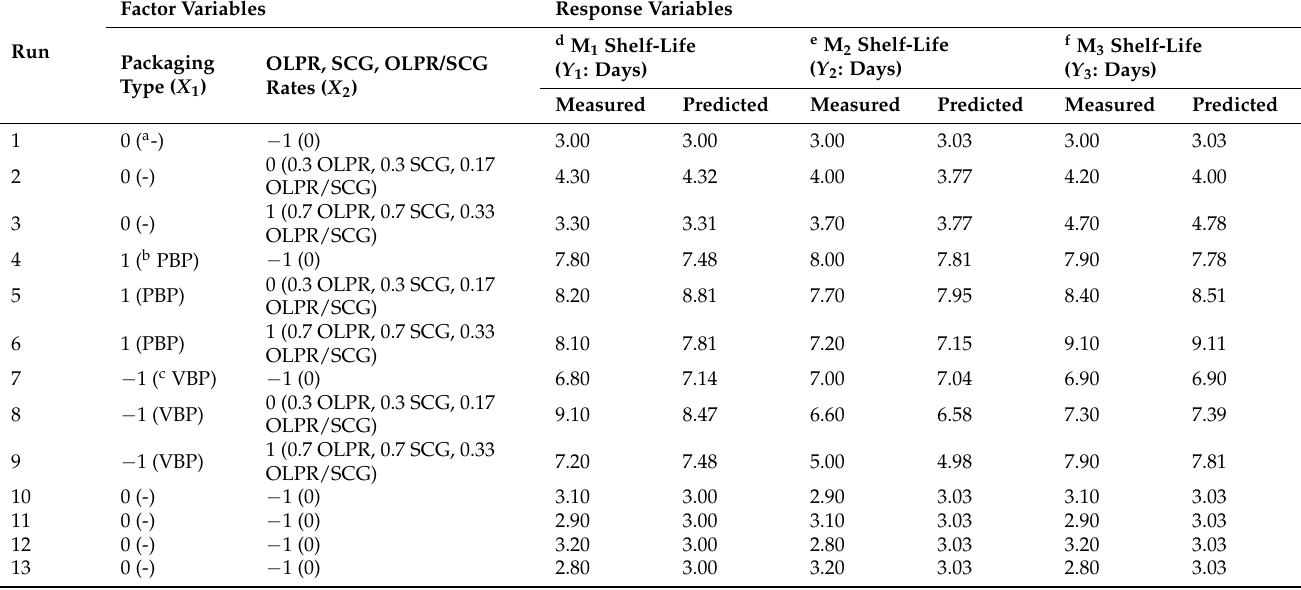
Table 2. Measured and predicted response matrix for the shelf life of mushrooms (days) stored at ambient